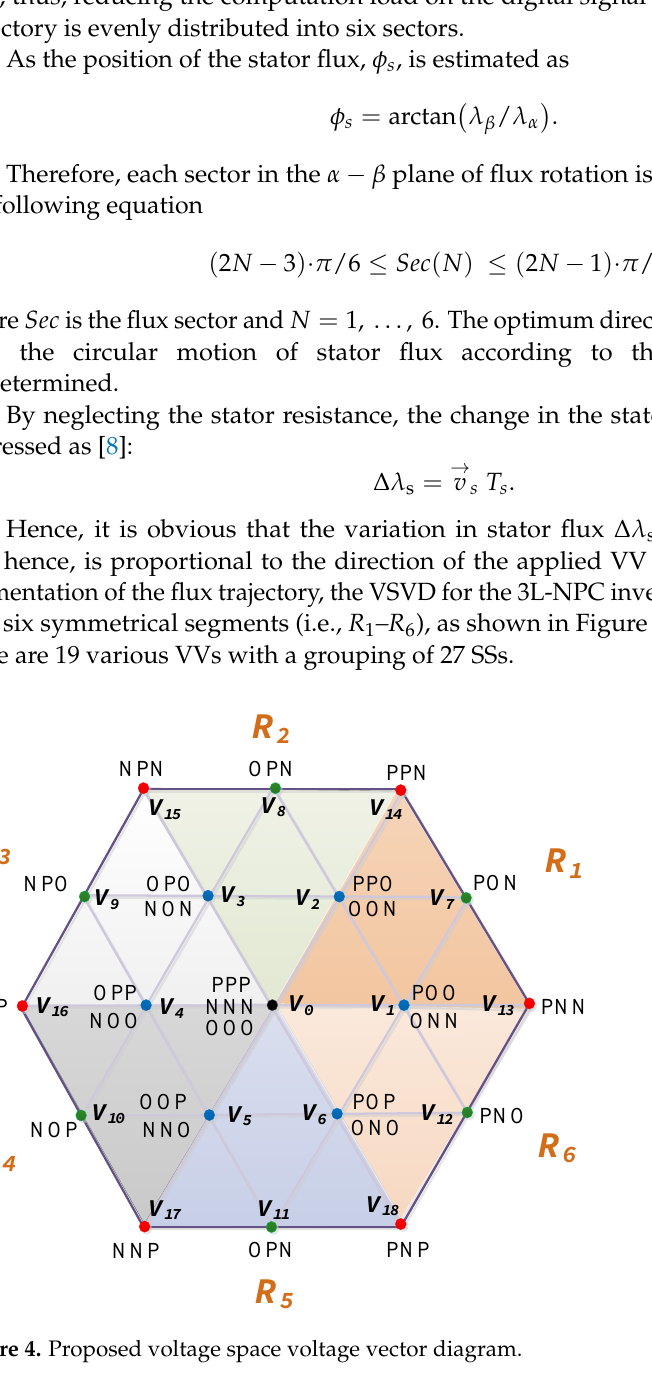
𝑉 𝑞 𝜆 𝑠 𝑉 𝑞𝜆 𝑠 𝑉 𝑞𝜆 𝑠 𝑉 𝑑𝜆 𝑠 𝑉 𝑑𝜆 𝑠 𝜆 𝑟𝑒𝑓 Figure 5. Illustration for the optimal candidate VVs for Sec (2) at ( a ) anticlockwise speed direction and ( b ) clockwise speed direction. Figure 5 shows the moving stator flux 𝜆 𝑠 at the instantaneous location of Sec (2) dur- ing the anticlockwise (forward) and clockwise (reverse) motor speed directions. It is ap- parent from Figure 5a,b that the optimal VSVD regions containing the admissible VVs are different for both speed directions. R 3 is the optimum region in the forward direction, and the 𝑅 6 is the optimal VSVD region in the reverse direction. For convenience, Table II shows the optimum VSVD regions for each flux sector. It can be observed that only six VVs out of nineteen VVs are processed during the cost function evaluation in each speed direction. The normal routine for controlling torque and flux is to include flux and torque error conditions for the preselection of VVs [26,28]. Nevertheless, this work uses the motor speed 𝜔 𝑟 for both VVs prediction selections because the rotor speed and flux rotation